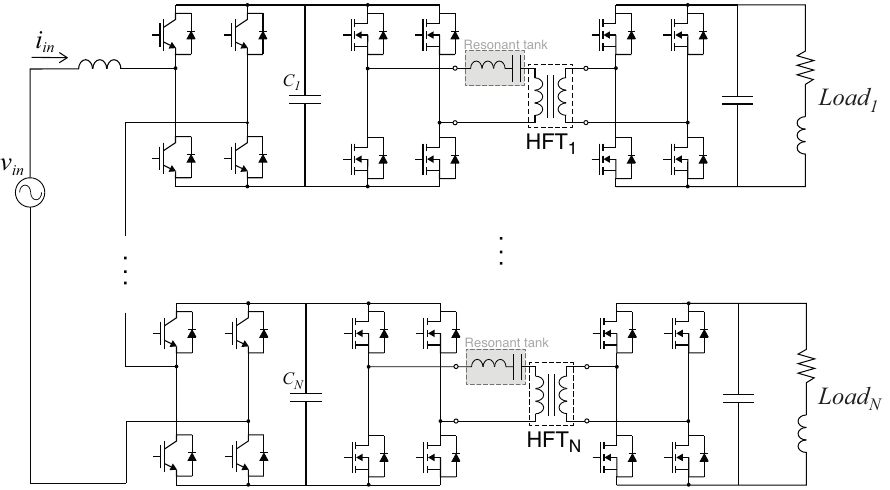
Figure 14. Two-stage SST topology with a CHBC and resonant DAB converters (adopted in [49]). This two-stage SST is formed by a cascaded H-bridge converter (CHBC) and resonant DAB converters (linked to the output of the CHBC cells). The proposed rectifier control method is divided into two main steps, which enable to significantly reduce the computa- tional burden of the overall control scheme. First, in order to achieve grid current reference tracking, the voltage level that the CHBC should generate at the AC-side is obtained from the FCS-MPC scheme. To achieve this, it is assumed that all capacitors are at the same voltage level ( V C ). Thus, it is also considered that the CHBC generates a discrete voltage level between − N ∗ V C and N ∗ V C (with a step of V C ), where N denotes the number of cells. For each of these 2 N + 1 possibilities, the input current will have a different value for sample k + 1. The FCS-MPC controller is used to predict all these current values and mini- mize a cost function that considers the error between the predicted current and respective reference for instant k + 1. After the cost function minimization, the selected voltage level